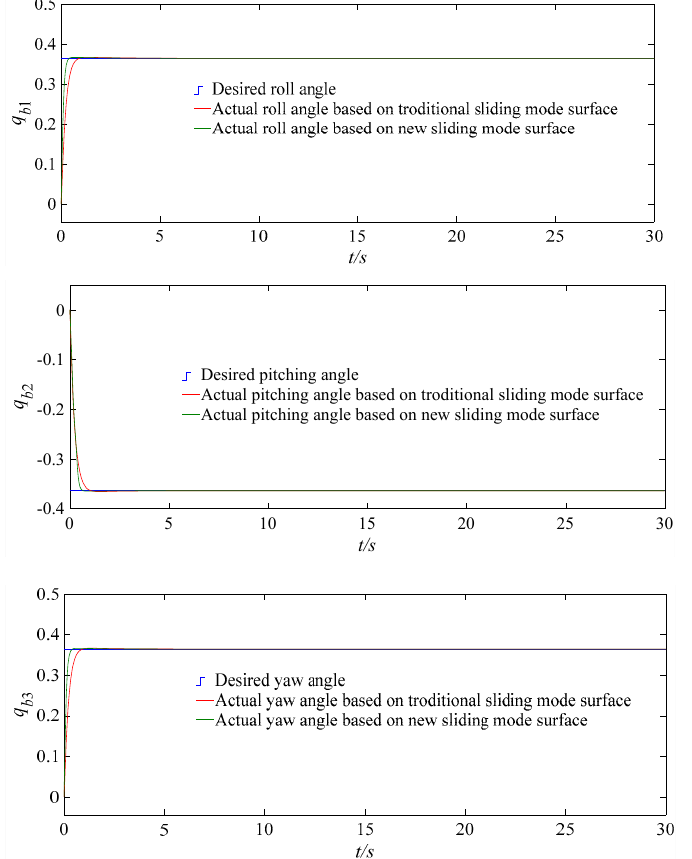
Figure 5. Tracking responses of UAV attitude angle under two sliding mode surfaces, with mis- matched disturbances and actuator failures .